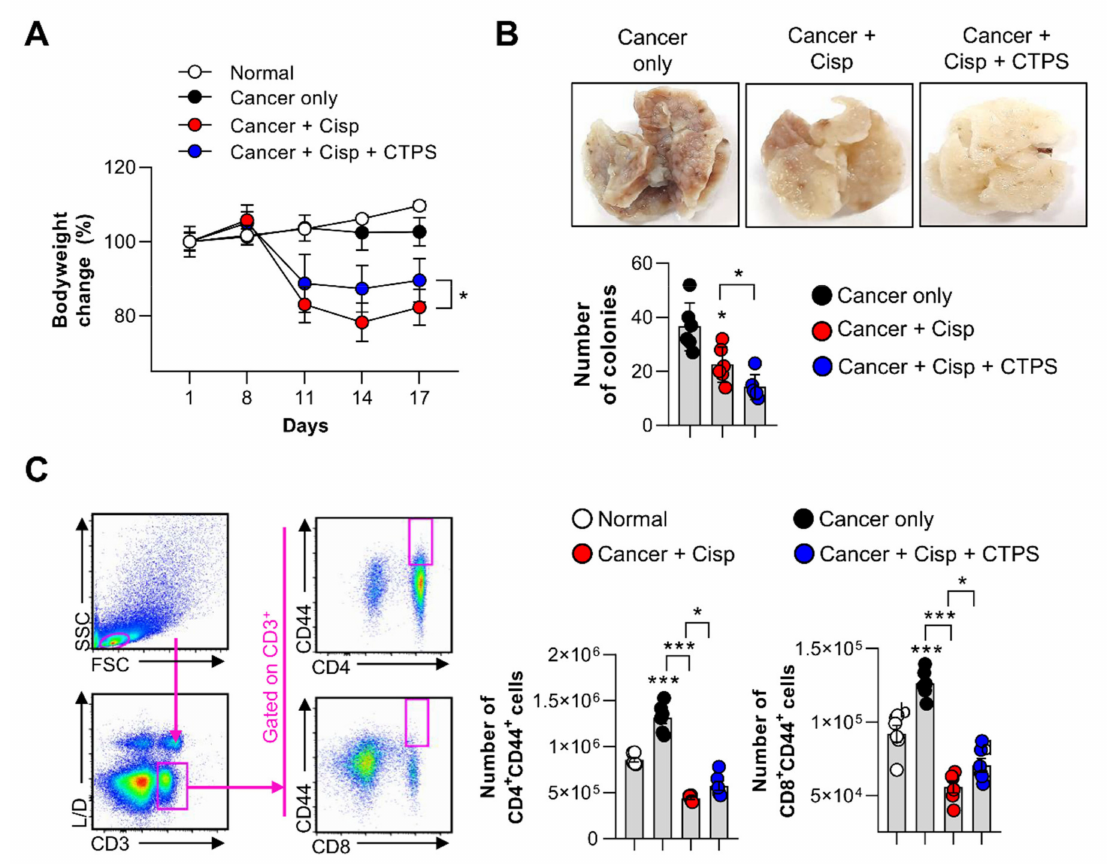
Figure 6. CTPS and cisplatin increase the anti-metastasis activity in C57BL/6 mice. ( A ) Change in body weight was monitored after the intravenous injection of mice with B16BL6 cells. CTPS (200 mg/kg) was orally administered daily. Cisplatin (10 mg/kg) was intraperitoneally administered on day 8. ( B ) Photographic representative images of lung tissues from each group of mice. The lung tissues were removed 17 days after injection. The metastatic colonies in the lung tissue were counted using a dissection microscope. ( C ) Single cells were isolated from the spleen of mice from each group and stained with anti-CD3, anti-CD4, anti-CD8, anti-CD44 monoclonal antibodies and subjected to the live/dead cell staining followed by flow cytometry analysis. The gating strategy is shown in the left panel. Bar graph shows the absolute number of CD4 + CD44 + or CD8 + CD44 + T cells. Data are expressed as the mean ± standard deviation ( n = 6). * p < 0.05 and *** p < 0.001 represent significant differences. CTPS, Cudrania tricuspidata -derived polysaccharides; cisp, cisplatin; CD3, cluster of differentiation; FSC, forward scatter; SSC, side